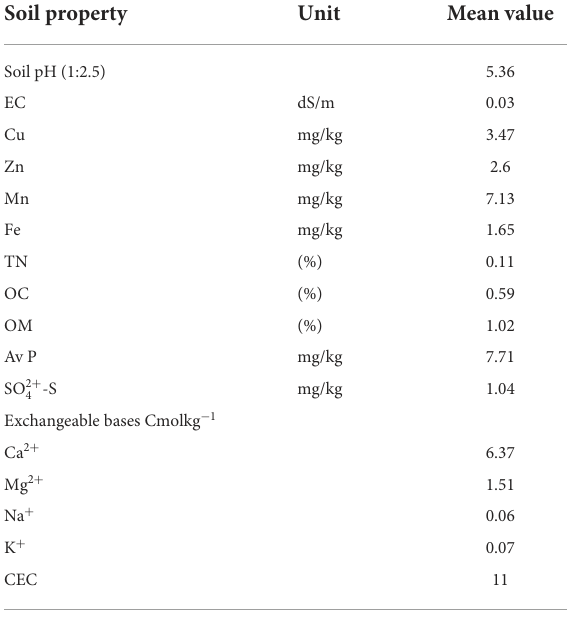
TABLE 3 Selected soil chemical properties of Mkindo Irrigation scheme at 0–20cm of soil used in the